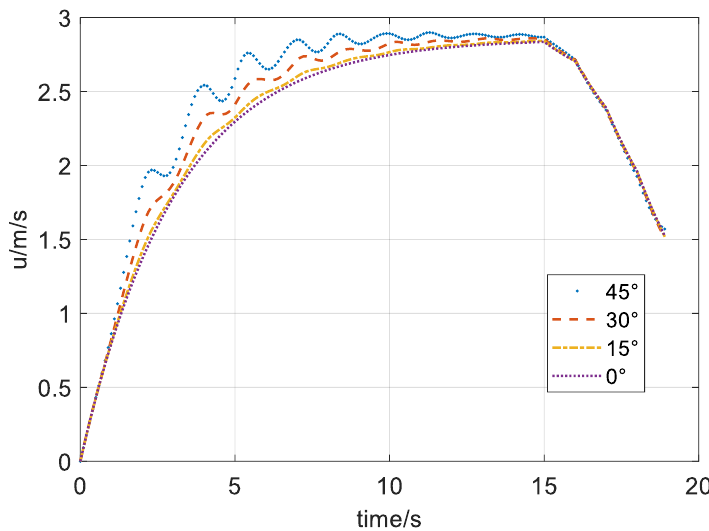
Figure 18. The change curve of forward speed u.